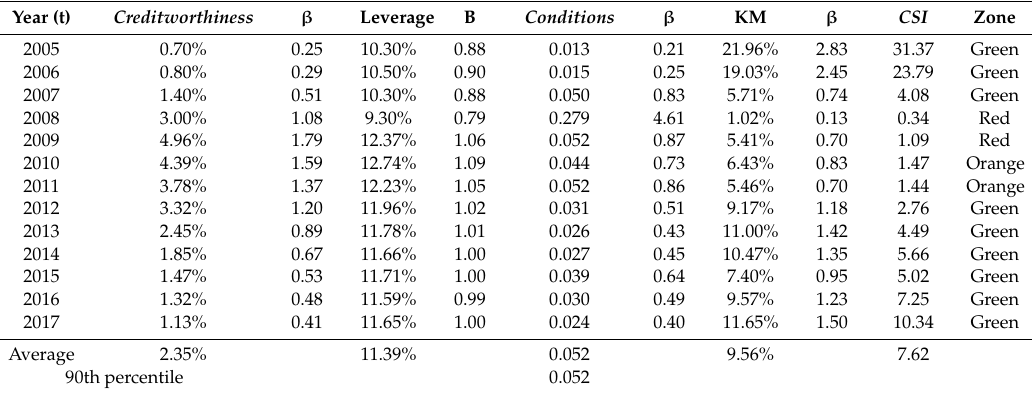
Table 2. Historical figures for the US banking market as a